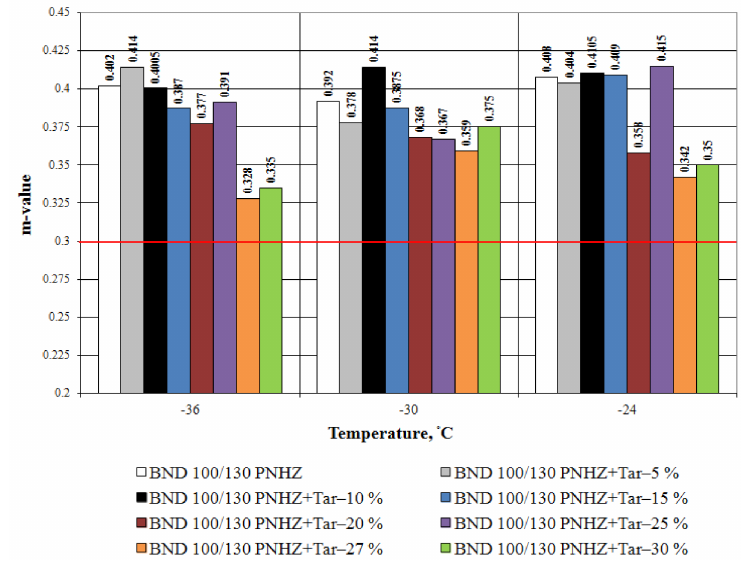
Figure 3. Them-value of the bitumen at various tar contents and different temperatures.